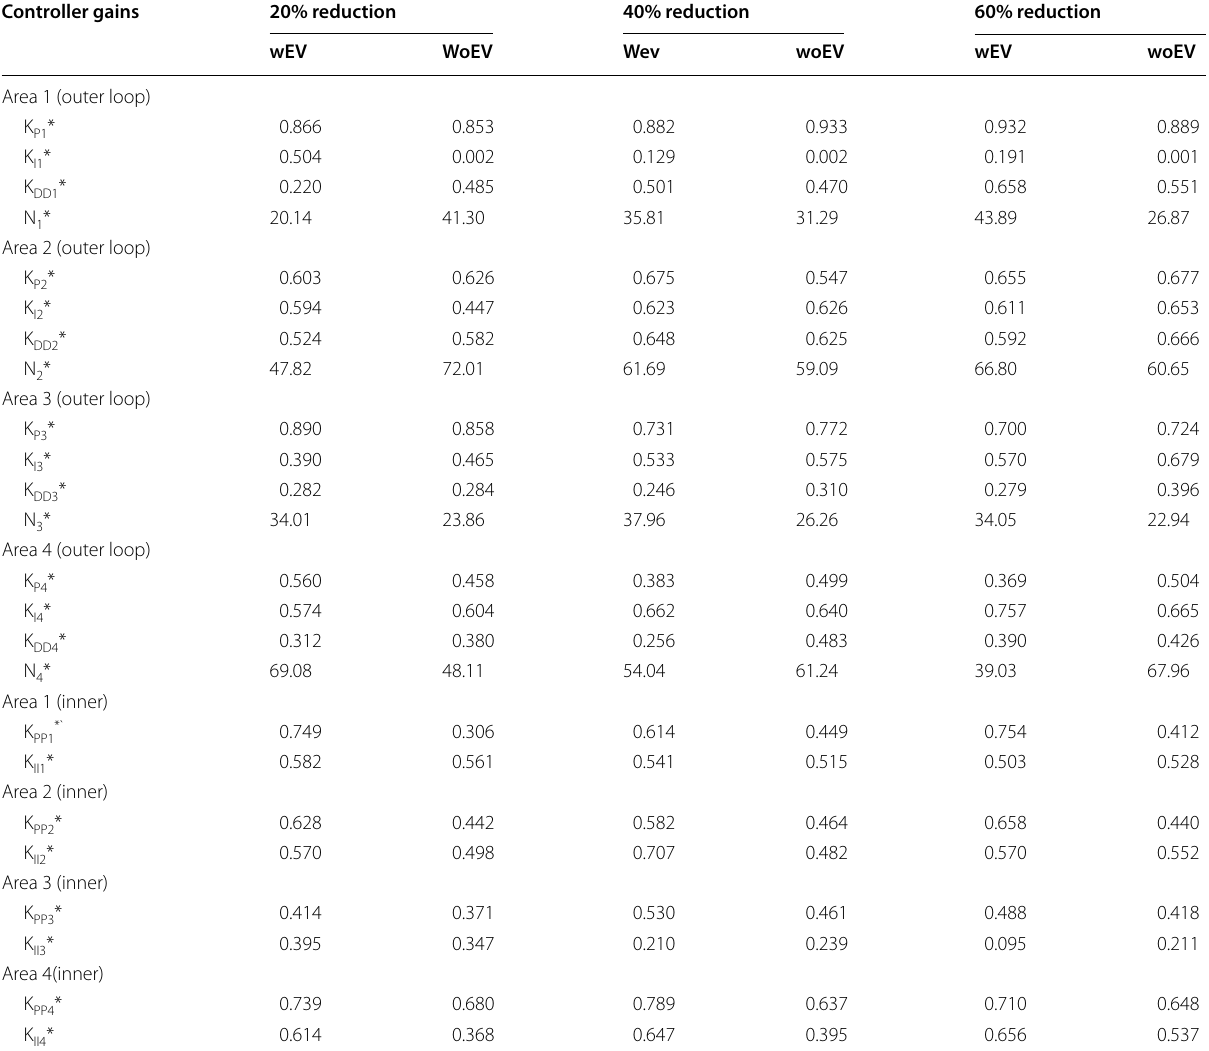
Table 5 Optimum controller gains with contract violation of 2% and reduced inertia of 20%, 40% and 60% Controller